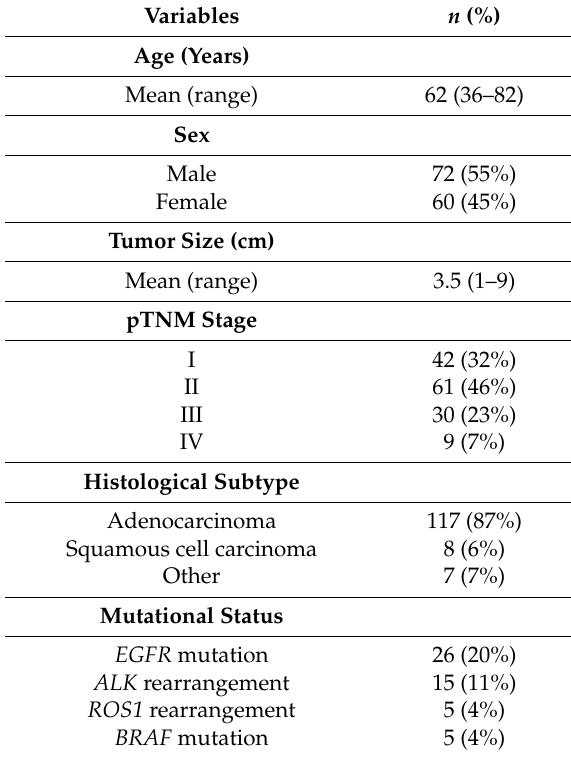
Table 1. Main epidemiological parameters associated with the cohort of non-smoker lung cancer patients (total of 132